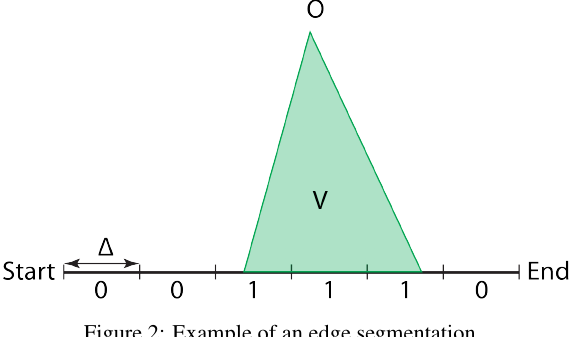
Figure 2: Example of an edge